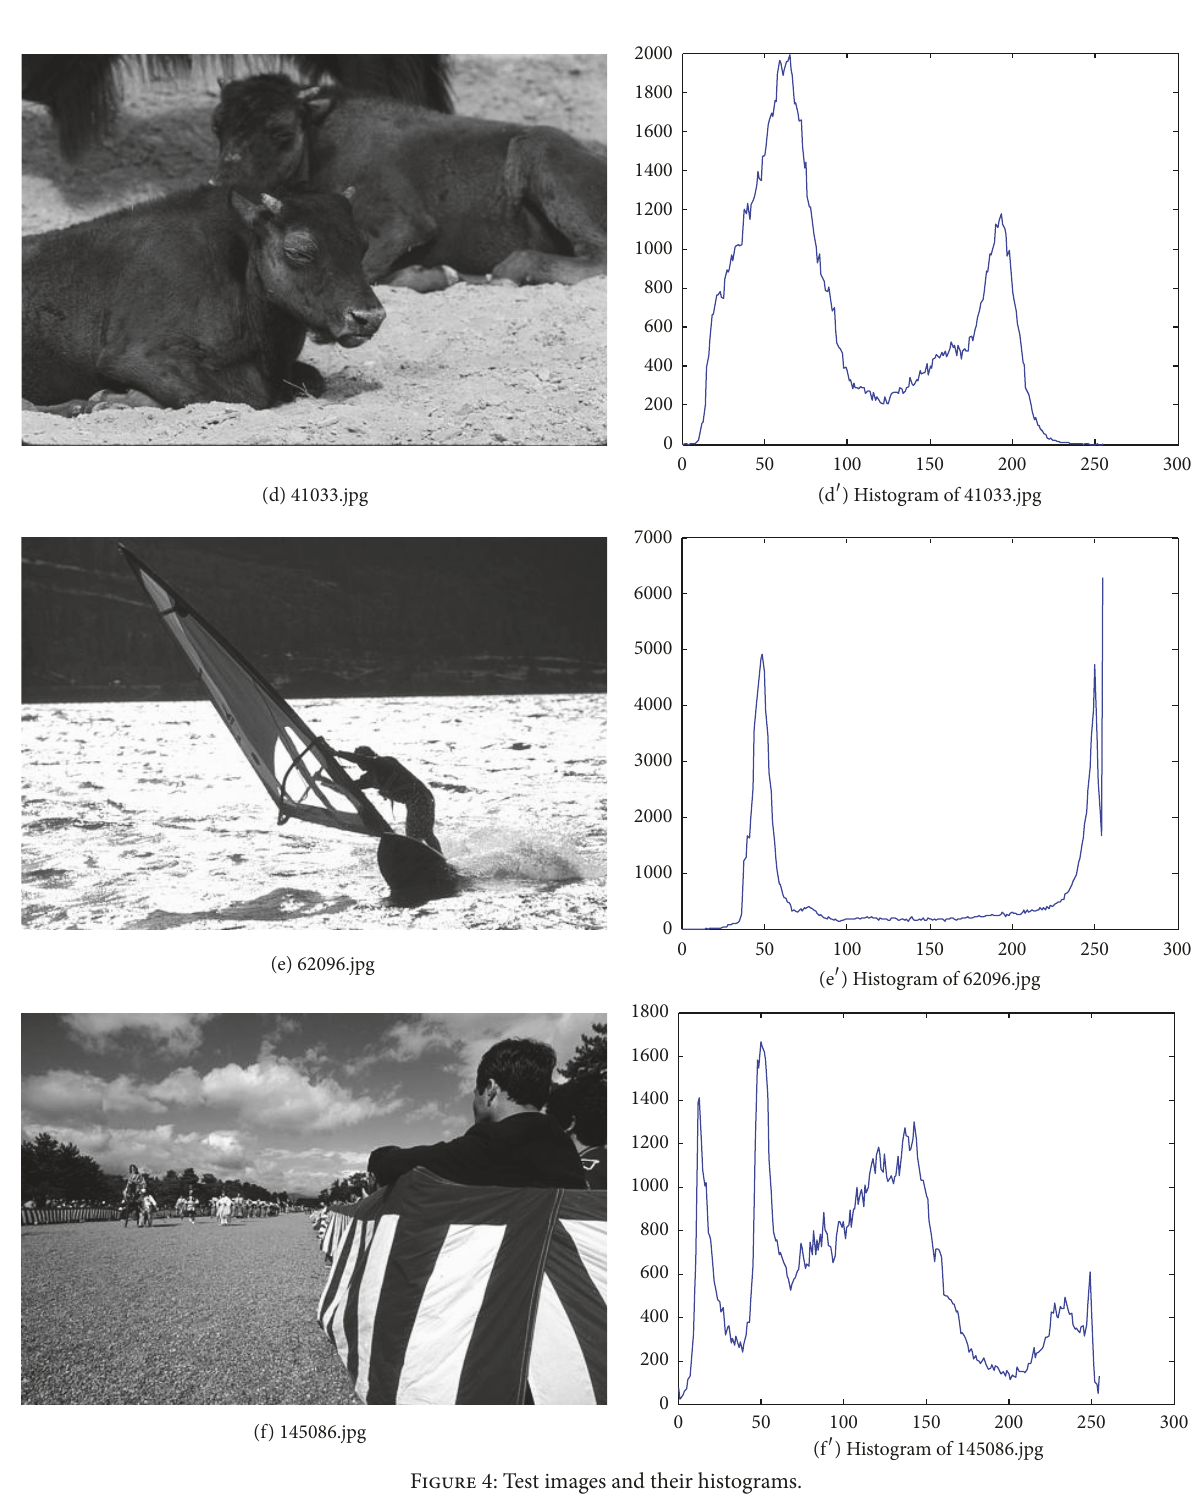
Figure 4: Test images and their